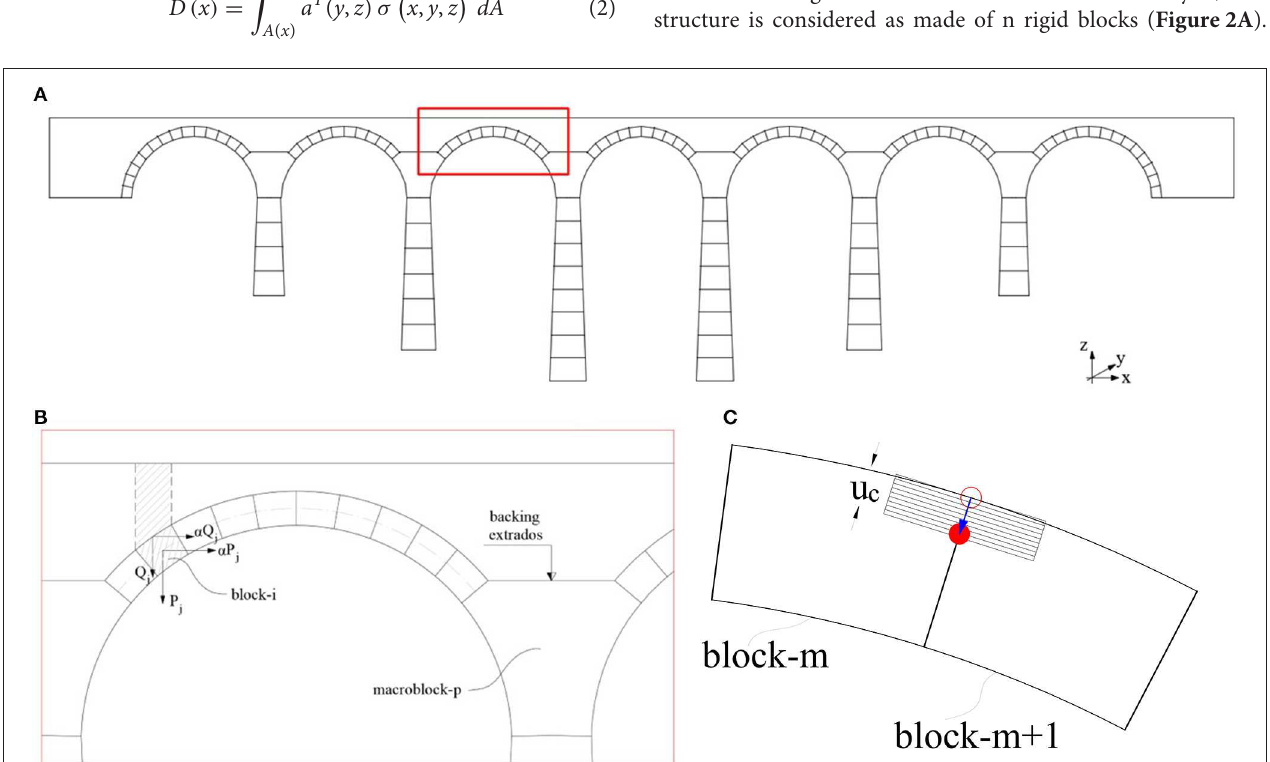
FIGURE 2 | Description of the non-linear kinematic models. (A) Subdivision in rigid blocks of the bridge. (B) Loads applied at the i-block (longitudinal analysis). (C) Hinge localization between two rigid blocks.